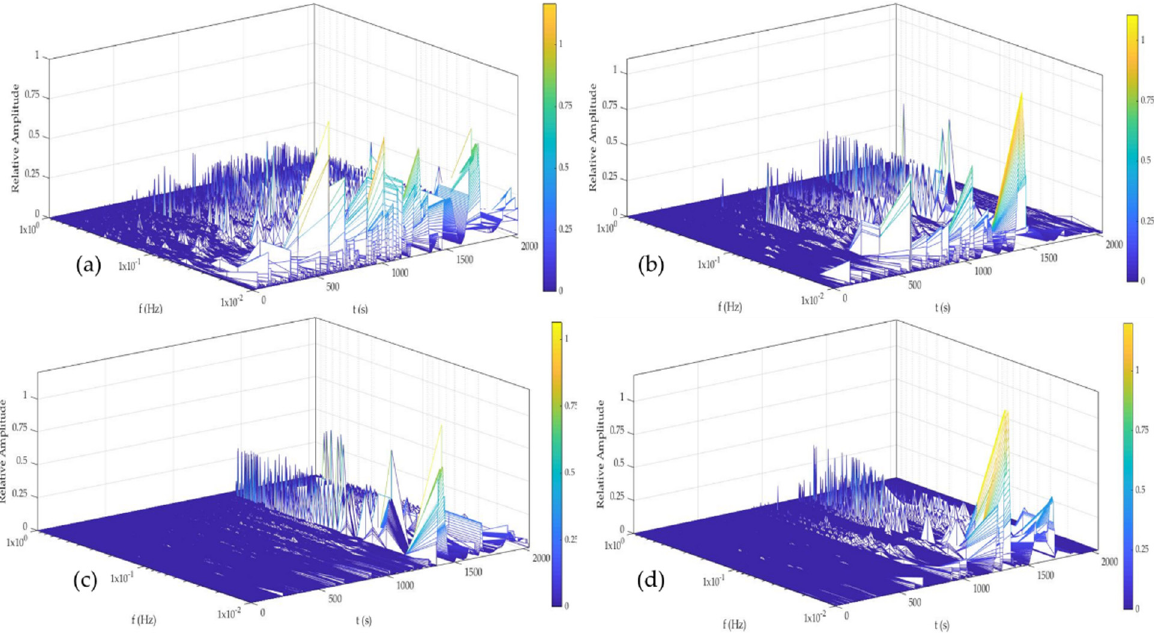
Figure 16. Hilbert spectra of Al-6061 in NaCl solution ( a ) 0 h, ( b ) 24 h, ( c ) 48 h, and ( d ) 120 h.